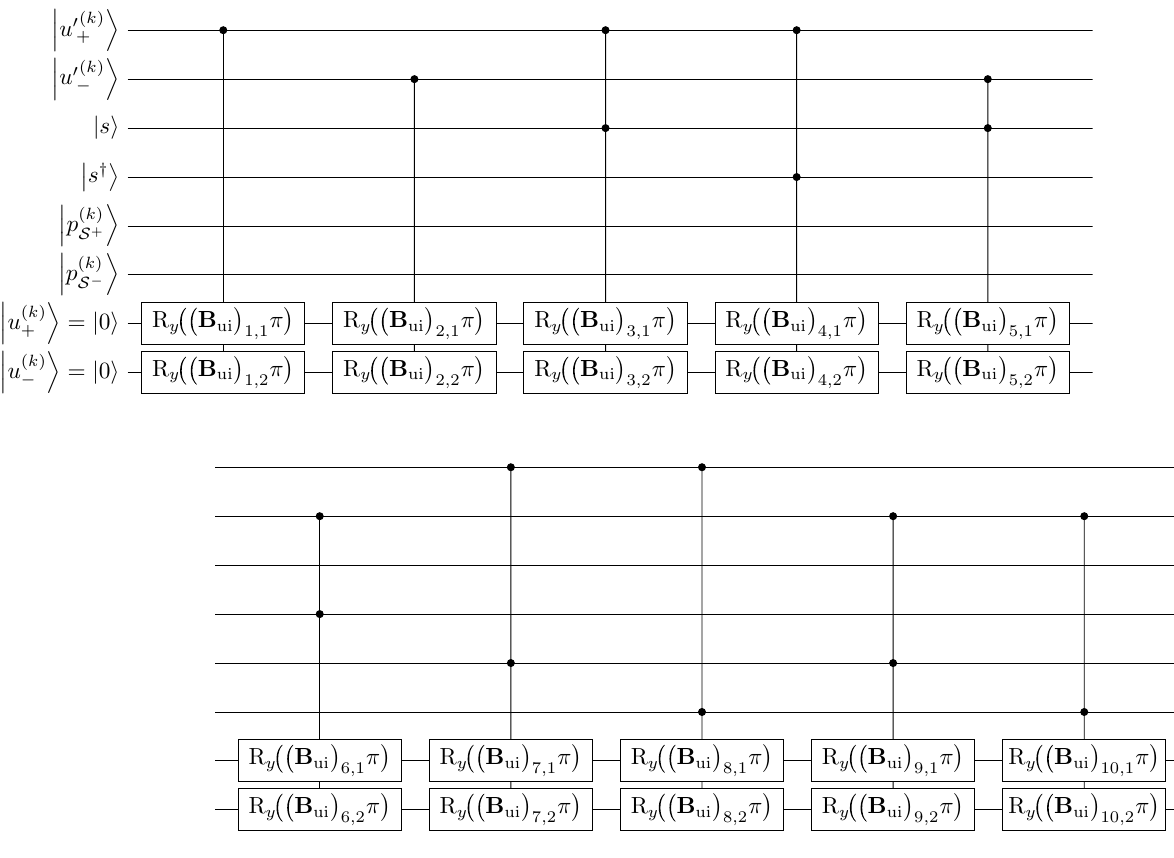
Figure 9. Extract of quantum algorithm for the evaluation process of use intentions, corresponding to Eqs. (S13) and